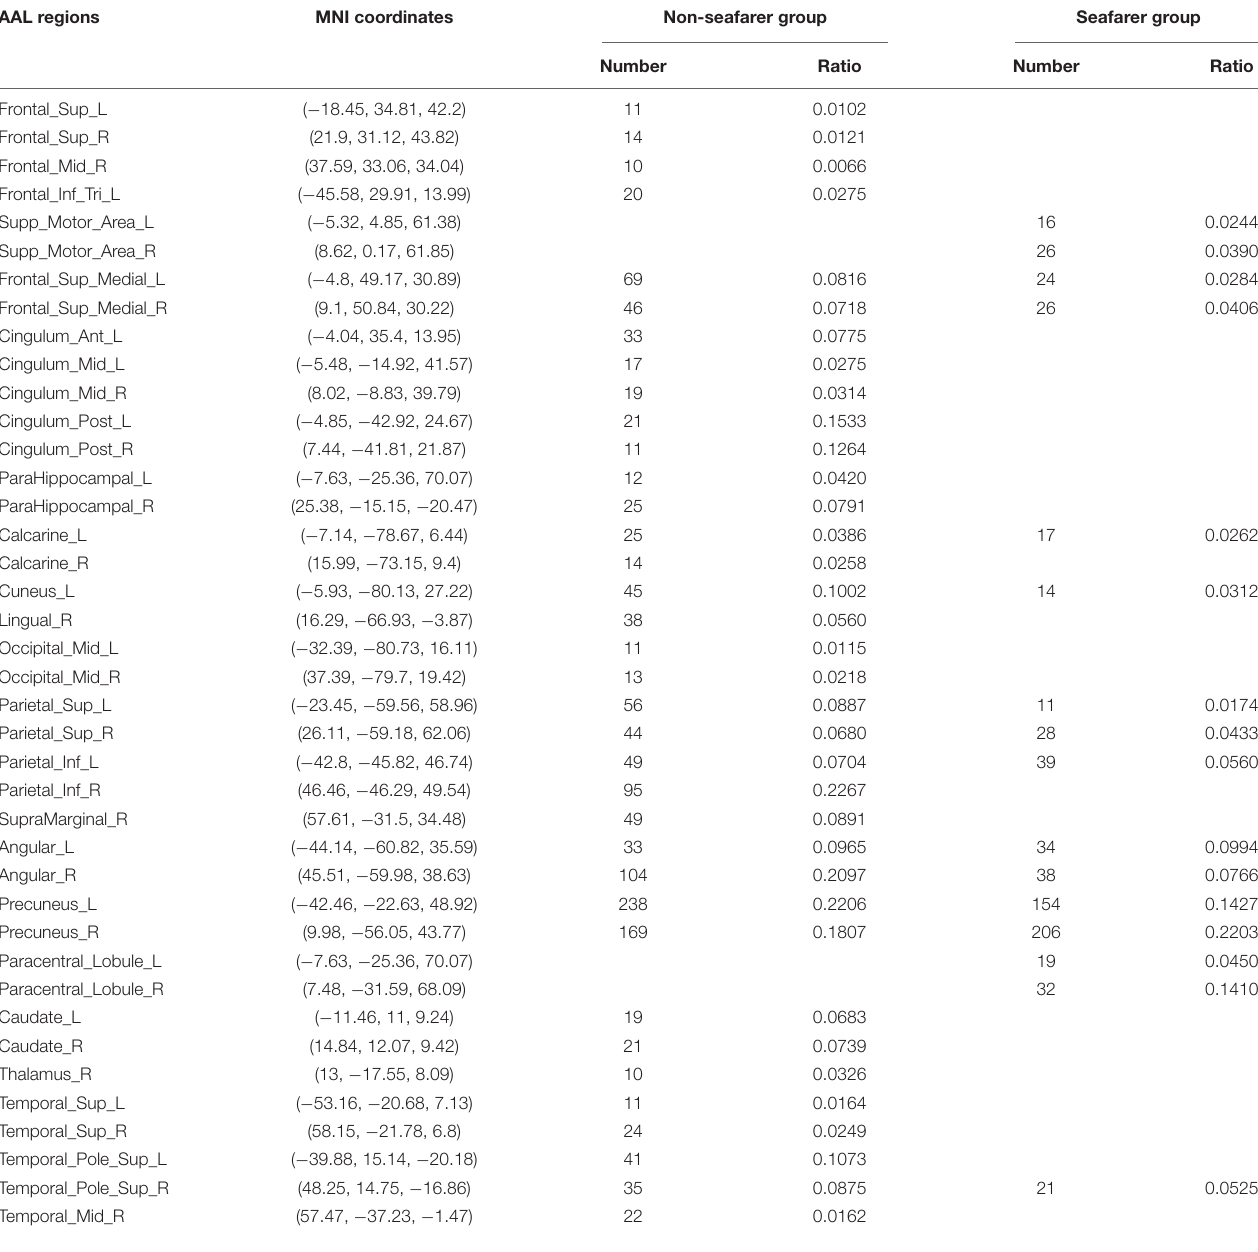
TABLE 1 | The statistical distribution of activated voxels of the non-seafarer group and seafarer group in the Anatomical Automatic Labeling (AAL) brain regions and their corresponding Montreal Neurological Institute (MNI) coordinates. AAL regions MNI coordinates Non-seafarer group Seafarer